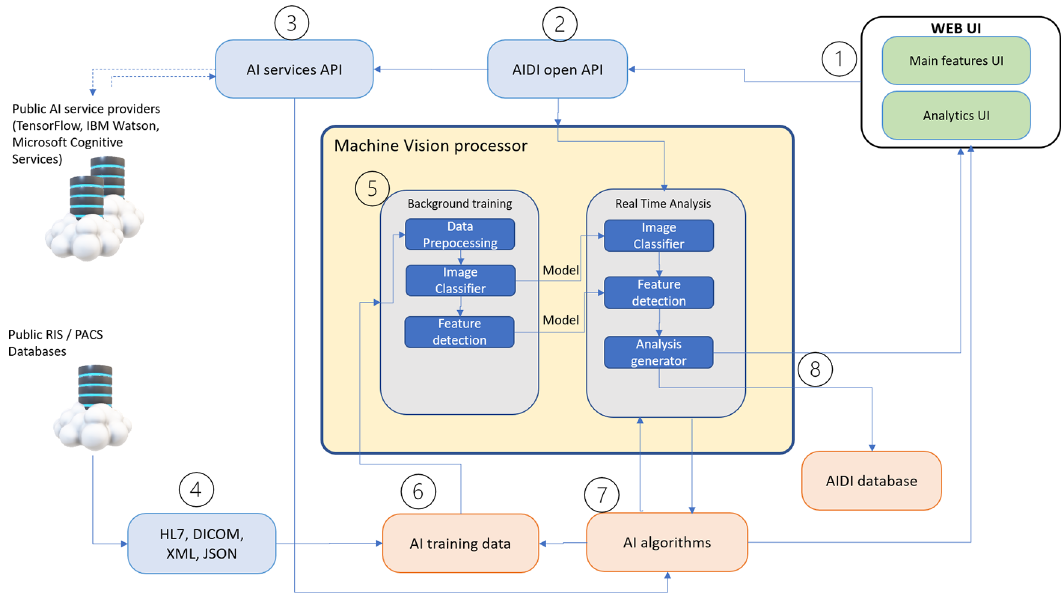
Figure 3. Automatic image diagnosis - process